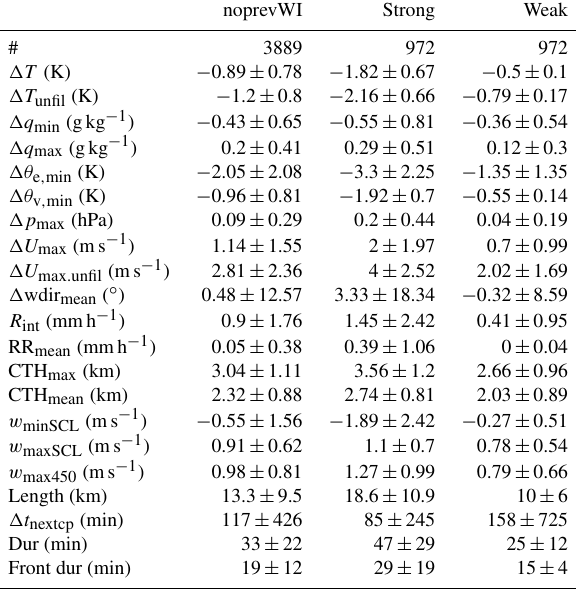
Table 1. Table showing median ± IQR of various cold-pool proper- ties for the noprevWI set of cold pools as well as the 25% strongest ( (cid:49)T < − 1 . 39K) and weakest ( (cid:49)T > − 0 . 61K) cold pools of this set. The computation of the diagnostics is explained in Sect.